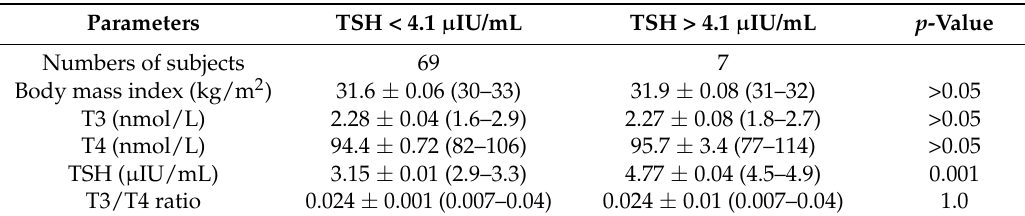
Table 4. Comparison of measured parameters in obese children and adolescents based on serum TSH levels (mean ± standard error of mean).